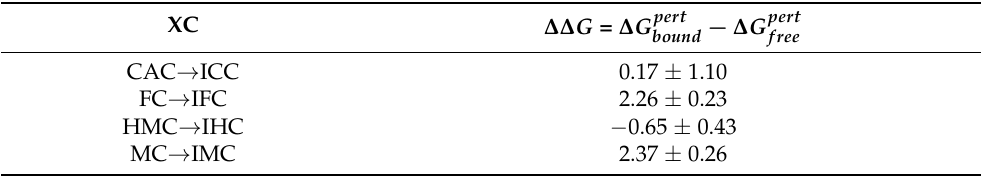
Table 6. Relative binding affinities [kcal/mol] of DNA with oxidised methyl-cytosine in amino and imino